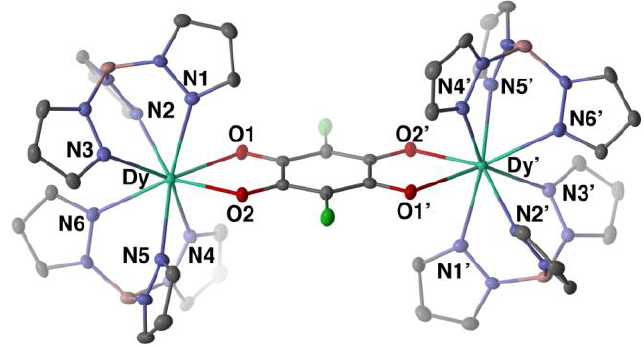
Figure 2. Molecular structure of 1 . H atoms and lattice solvent molecules are omitted for clarity.